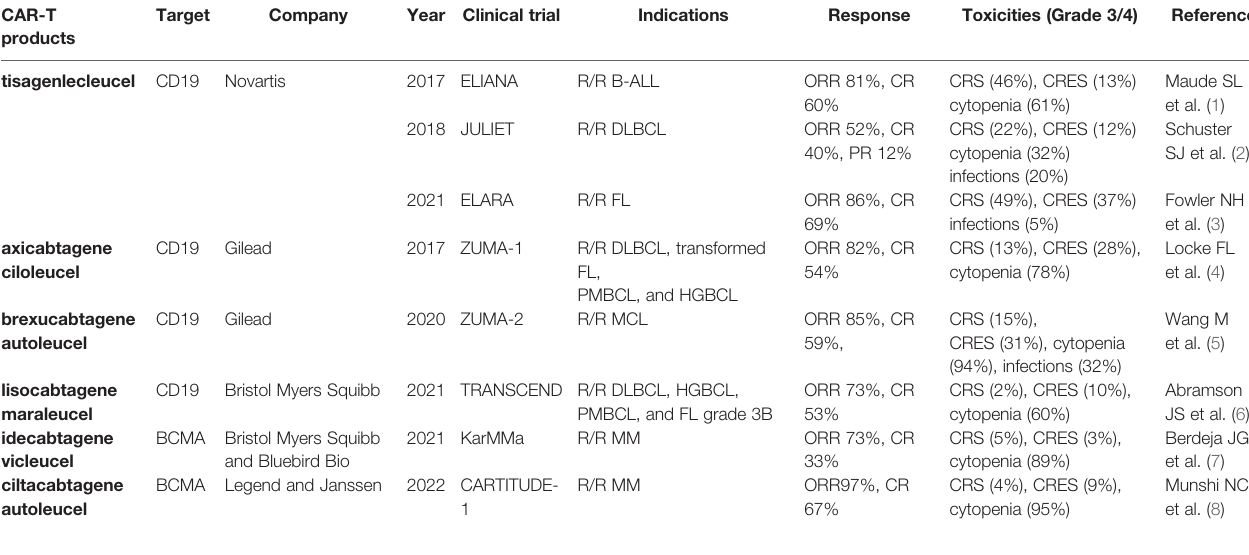
TABLE 1 | Landmark clinical trials of FDA-approved CAR-T cell products. CAR-T